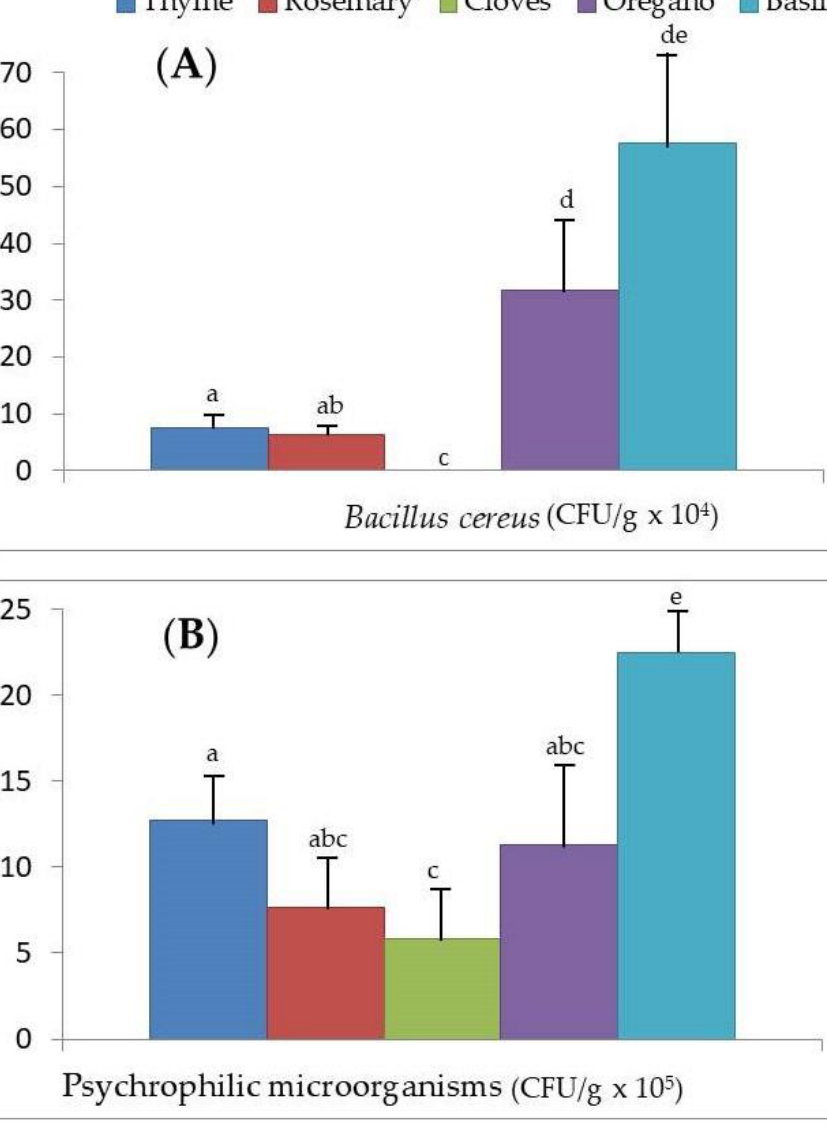
Figure 3. Microbial counts measured as colony-forming units (CFU / g) for ( A ) Bacillus cereus and ( B ) psychrophilic microorganisms after the addition of the dehydrated aromatic herbs (thyme, rosemary, cloves, oregano, and basil) to the culture medium. a,b,c,d,e Mean microbial counts; different superscripts indicate significant differences between the aromatic herbs ( p < 0.001).